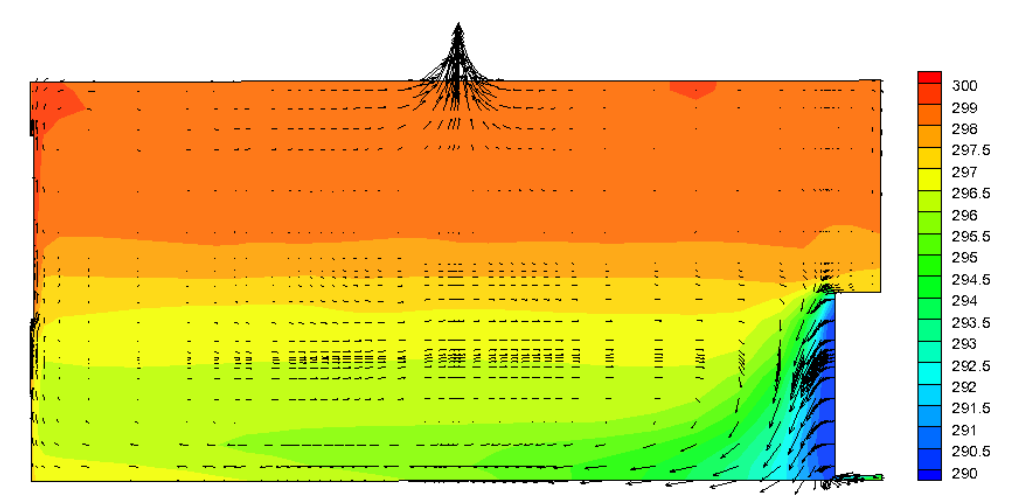
Figure 4. The steady temperature contour (K) and airflow pattern computed by the CFD program (the midsection through the